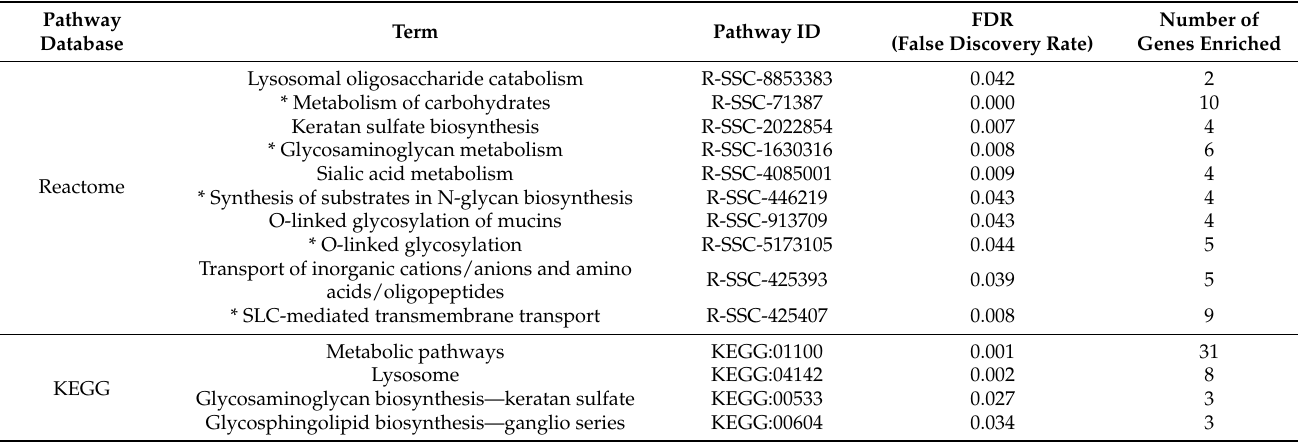
Table 3. Pathways significantly enriched by the downregulated genes in heat stress placentae ( n = 5) compared with control placentae ( n = 5).